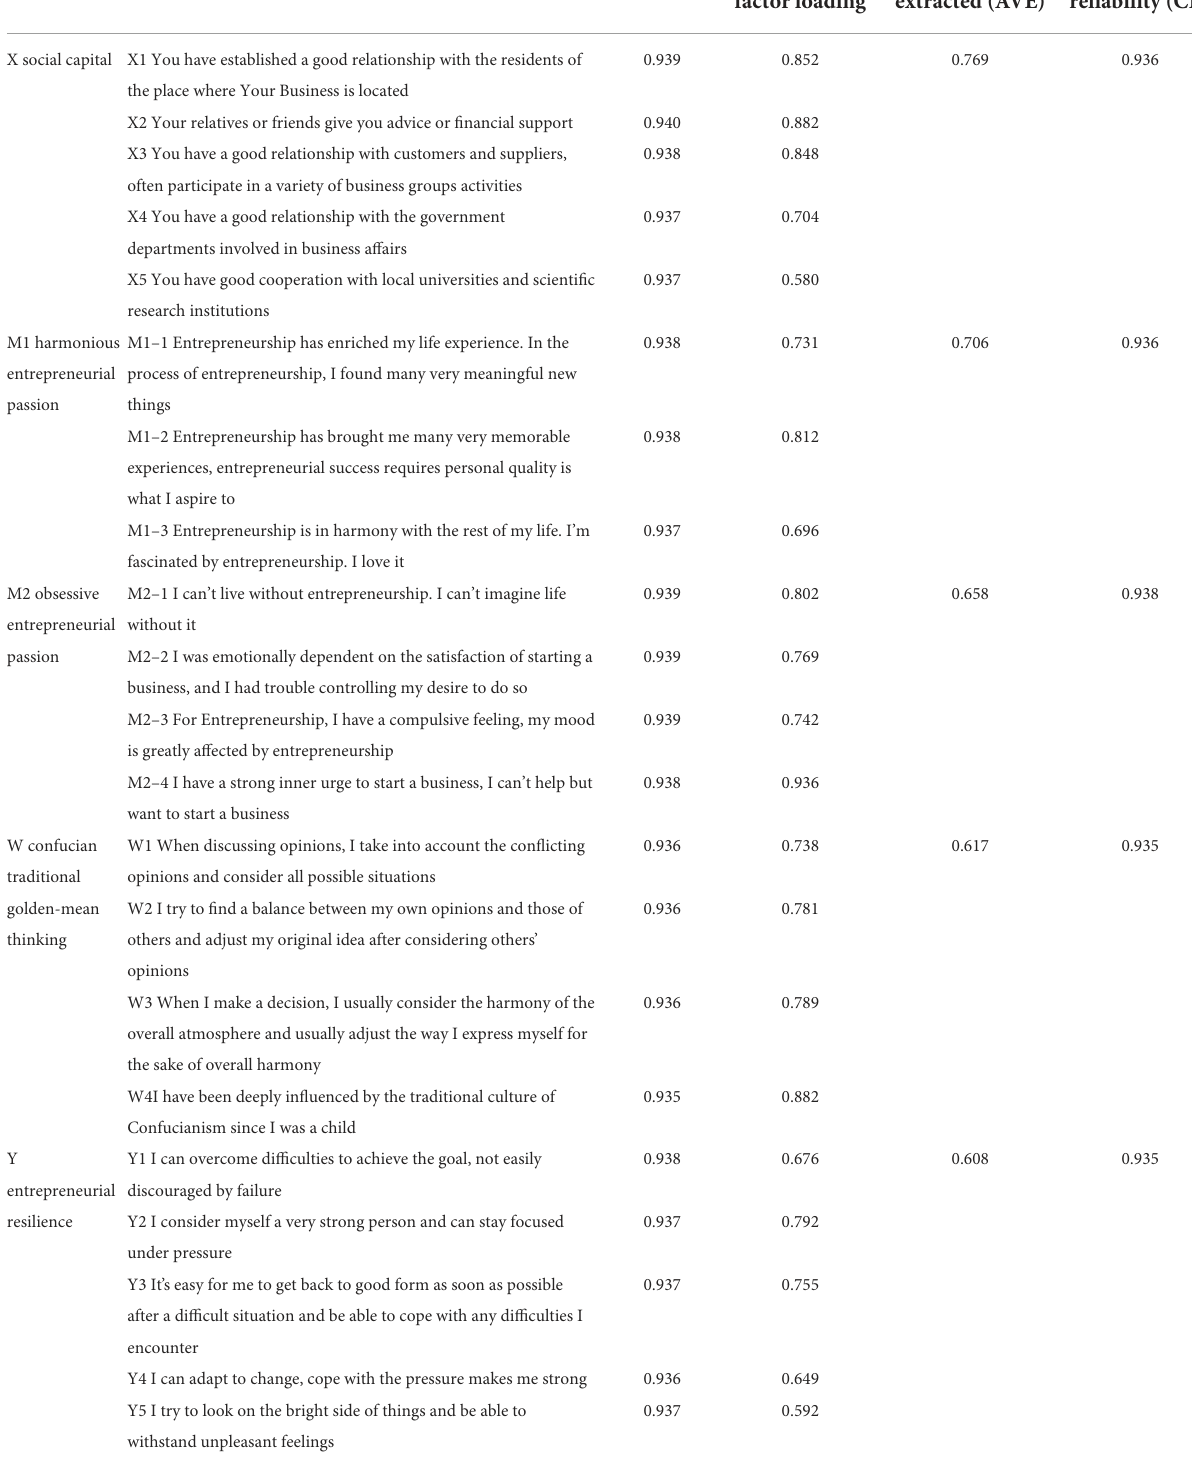
Average variance Composite factor loading extracted (AVE) reliability